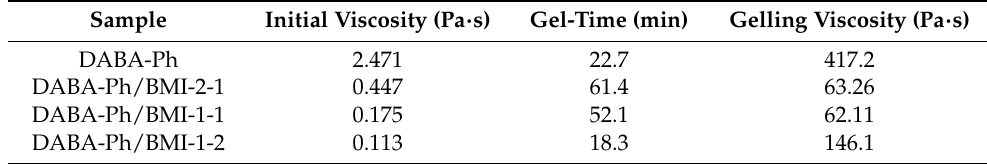
Table 2. Viscosity and Gel-time of DBPA-Ph/BMI Prepolymer at 180 °C .